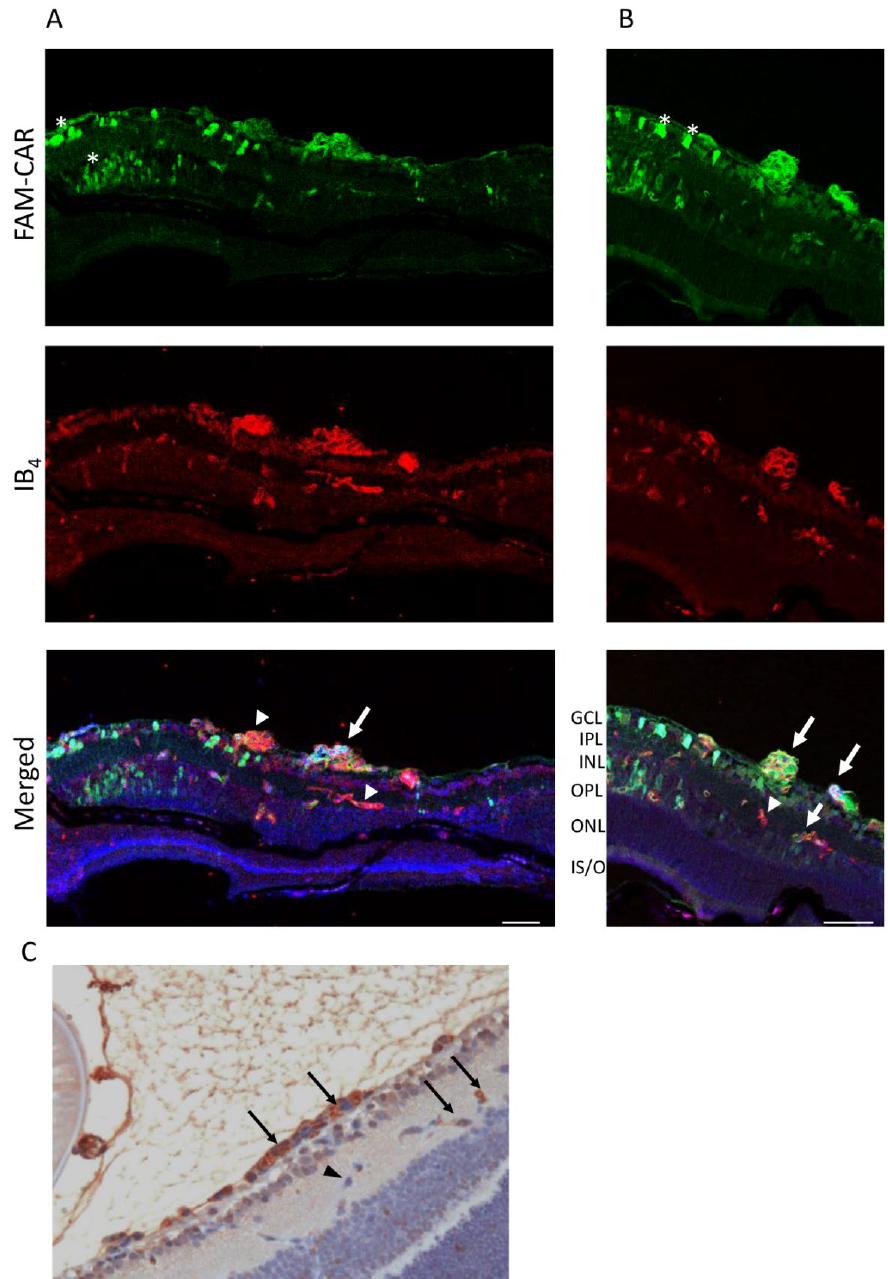
Figure 5. Intravitreally administered CAR-peptide binds to preretinal tufts and to the blood vessels deeper in the retina . The CAR peptide was administered intravitreously. Whole eye cross sections were stained with Isolectin B 4 to label the blood vessels (in red) and the FAM-conjugated CAR-peptide is visible in green ( A , B ). The CAR-peptide was seen in the blood vessels (arrows) in different retinal layers, while some of the retinal blood vessels remained negative for CAR homing (arrowheads). CAR-homing was also seen in the neural retina, especially in GCL and INL layers (asterisks). Retina cross sections were also stained with anti-FITC antibody and the immunohistochemical signal was imaged by light microscope ( C ). The staining revealed strong CAR peptide homing/binding to preretinal neovascular tufts, but also some blood vessels in the deeper retina (arrows ( C ). ( N = 2) GCL, ganglion cell layer; IPL, inner plexiform layer; INL, inner nuclear layer; OPL, outer plexiform layer; ONL, outer nuclear layer; IS/OS, inner and outer segments. Scale bars represent 50 µm ( A – C ).